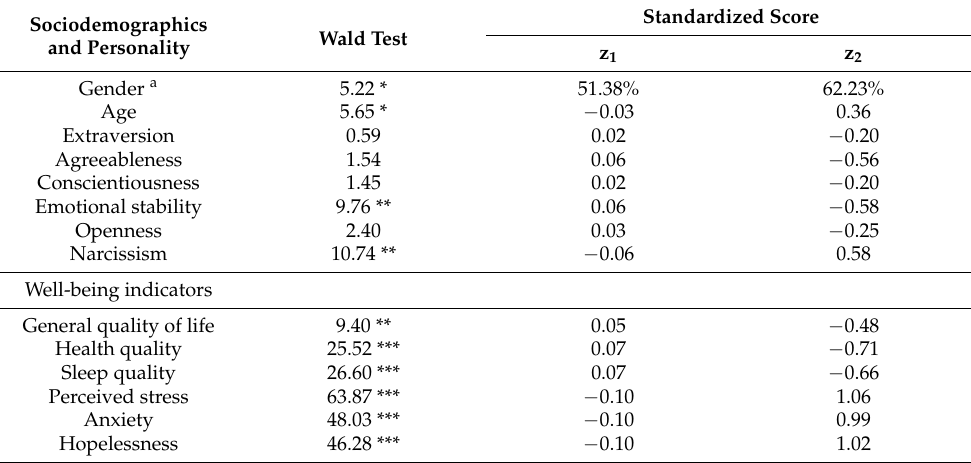
Table 7. Potential Predictors and Outcomes of LPA Membership: Comparison of Classes. Sociodemographics and Personality